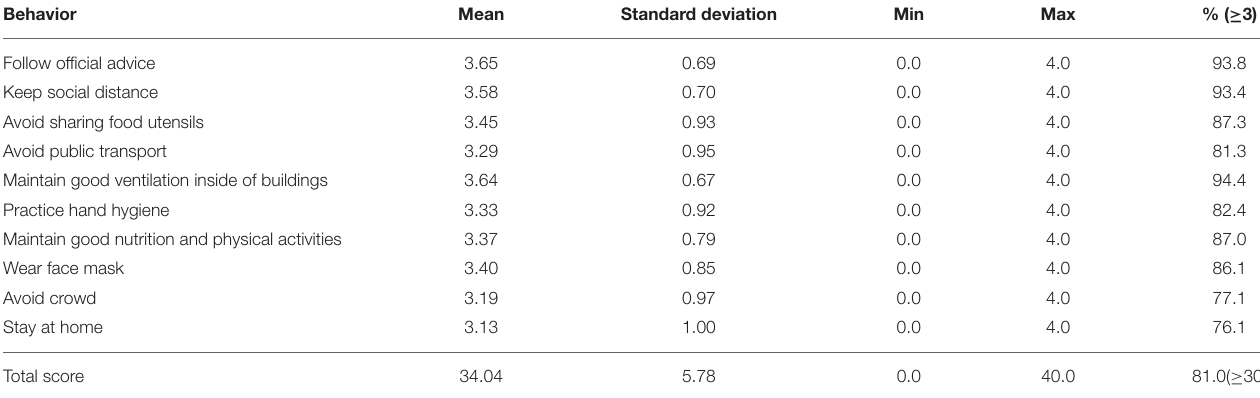
TABLE 2 | Protective behaviors endorsed by